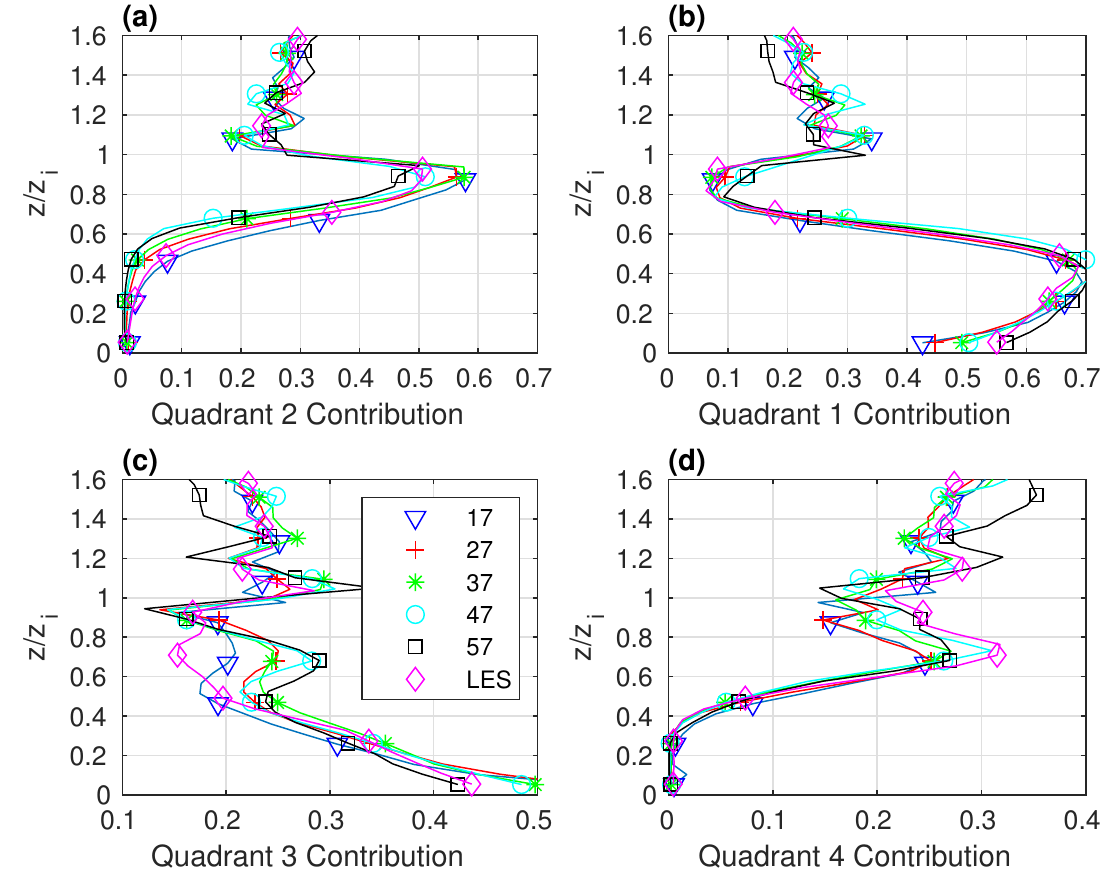
Figure 17. Effect of mixing length on the partitioning of the resolved potential temperature flux into different quadrants for CBL1 runs with 160 m grid spacing. Relative contributions of the flux in each quadrant, computed as |(cid:104) w (cid:48) θ (cid:48) (cid:105) i | / ∑ i |(cid:104) w (cid:48) θ (cid:48) (cid:105) i | , are shown for ( a ) Quadrant 2, ( b ) Quadrant 1, ( c ) Quadrant 3 and ( d ) Quadrant 4. Each line is for a simulation with a different value of the asymptotic mixing length, the values in m being indicated in the inset. LES results from the 10 m simulation are also